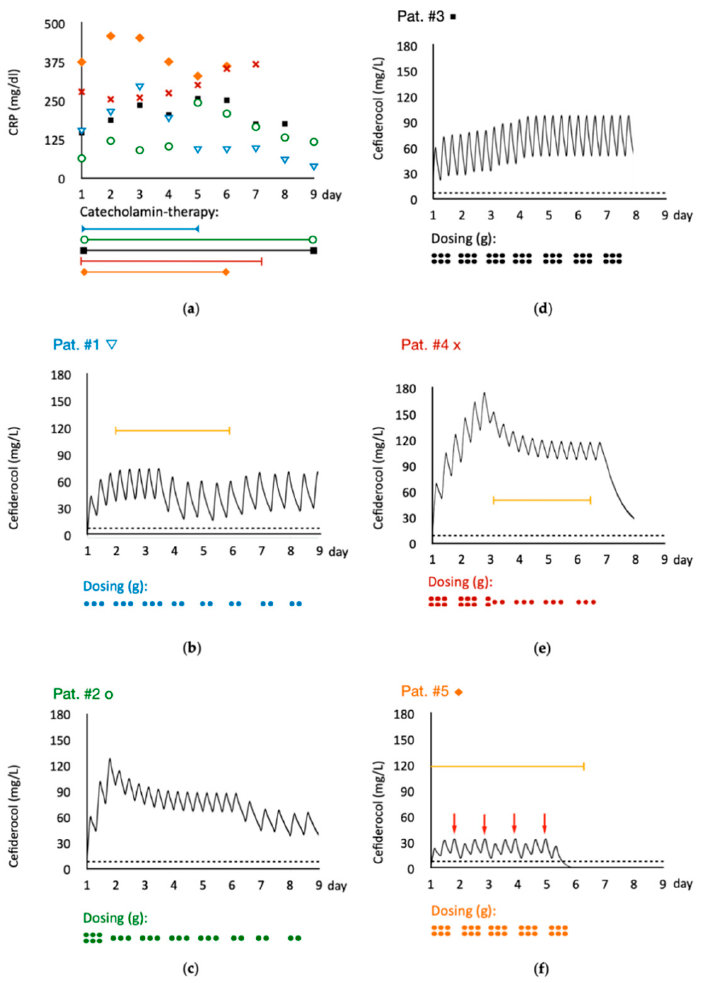
Figure 1. Clinical courses and cefiderocol levels of individual patients. The color scheme is applied consistently for all parts of the figure; blue = patient #1; green = patient #2; black = patient #3; red = patient #4; orange patient #5. ( a ) demonstrates individual courses of C-reactive protein for each patient. In addition, bars at the bottom indicate the duration of catecholamine therapy for each patient. ( b – f ) demonstrate the individual cefiderocol levels simulated based on the measured trough levels. Dotted horizontal lines denote the cut-off for sensitivity for the pathogen isolated from each patient according to EUCAST. Yellow bars present the durations of continuous renal replacement therapy. The daily cefiderocol dosage is displayed by dots at the bottom of each patients’ graph. Each dot denotes one gram of cefiderocol. Red arrows in part ( f ) indicate the change of CytoSorb ® cartridges with measured consecutive drops of cefiderocol plasma levels.